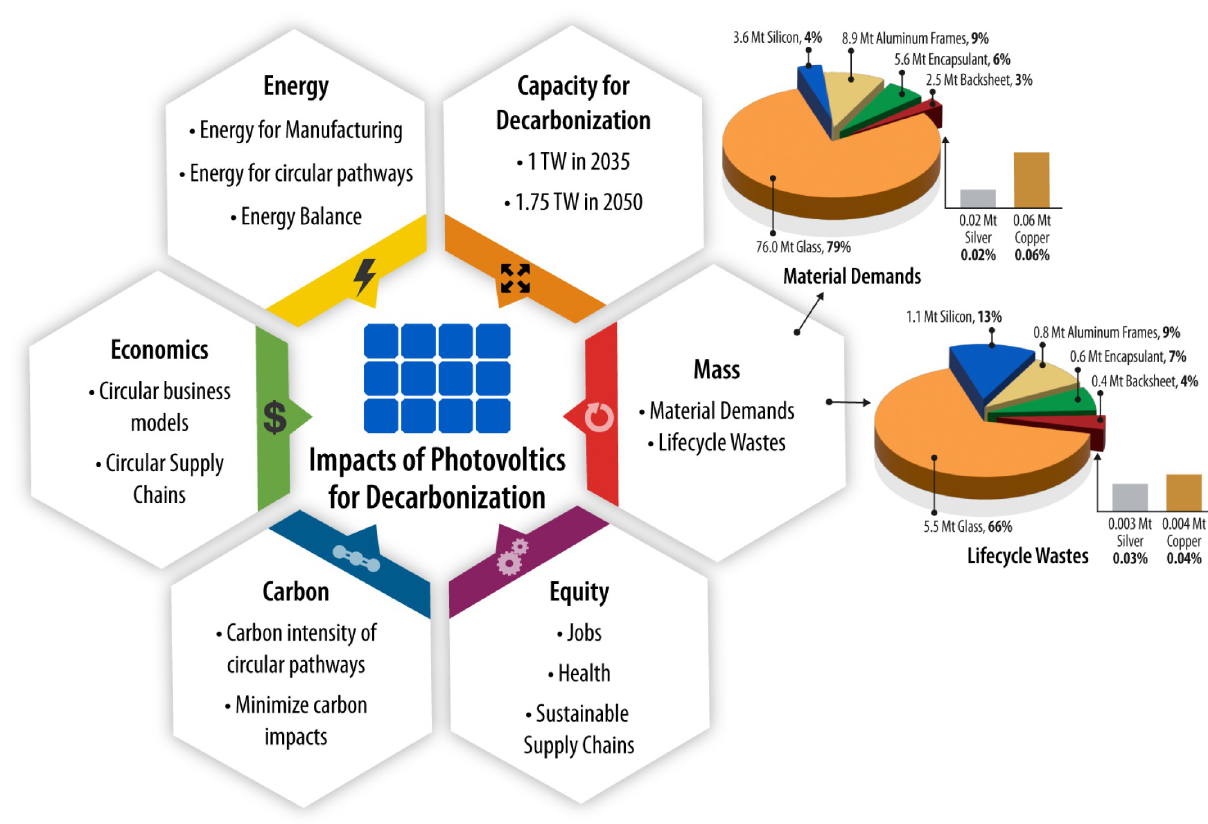
Fig 7. Holistic dimensions to evaluate circular PV for decarbonization. Dimensions and metrics for holistically evaluating circular PV design and life cycle management. The pie charts present the component material breakdowns of material demands and life cycle wastes for expected technology trends (PV ICE baseline) through 2050. Mt is million metric